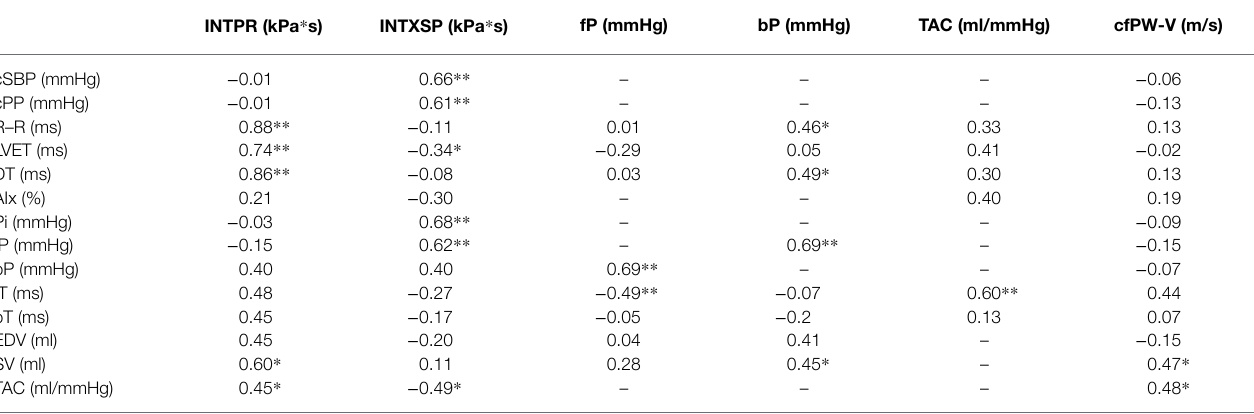
TABLE 2 | Correlation coefficients of reservoir pressure, excess pressure, separated backward and forward pressures, total arterial compliance and aortic stiffness with systemic haemodynamics parameters.